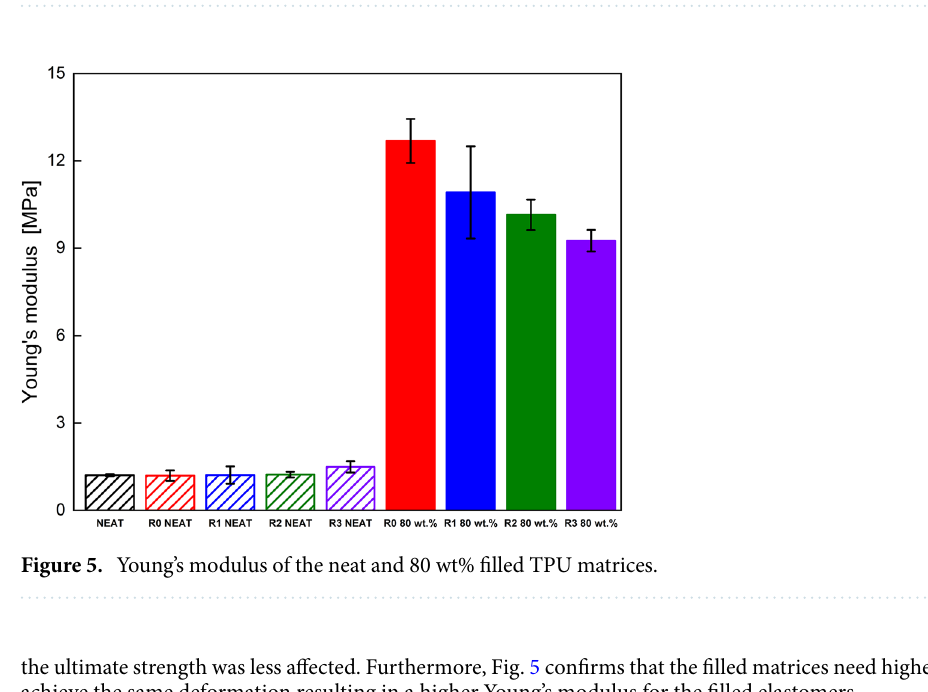
Figure 4. Tensile strength of the neat and 80 wt% filled TPU samples.